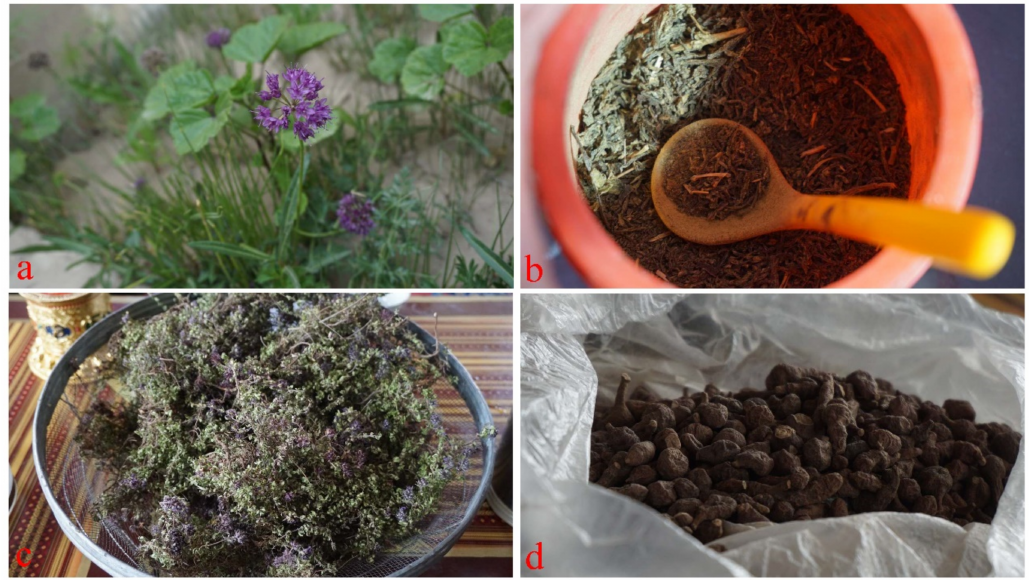
Figure 5. Three wild edible